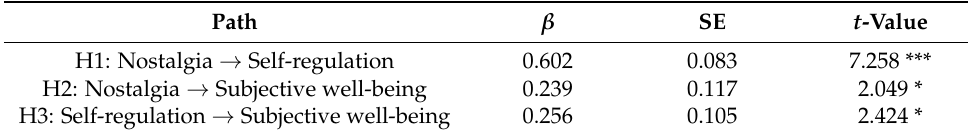
Table 4. Results of the hypothesized model.